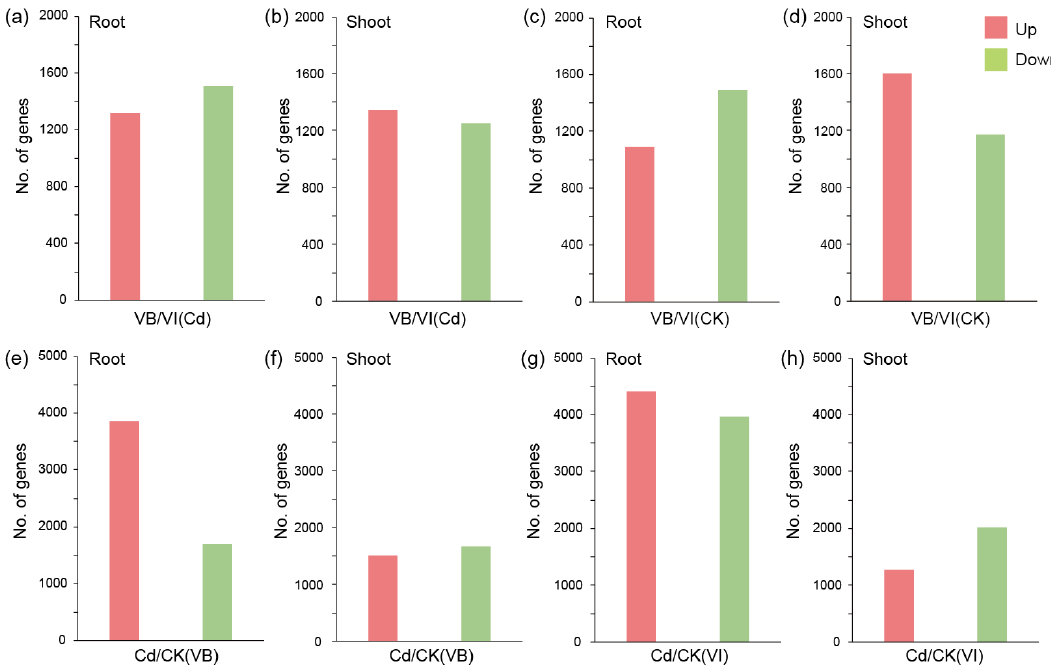
Figure 3. Differentially expressed genes (DEGs) between Cd-treated and control samples in both Viola species. Numbers of the genes with significantly different transcription levels (up- or downregulated) between two species in roots ( a ) and shoots ( b ) under the Cd stressed condition, or in the roots ( c ) and shoots ( d ) of the control samples, were summarized for comparison. DEGs between the Cd treated and control samples in VB roots ( e ), VB shoots ( f ), VI roots ( g ), and VI shoots ( h ). CK, control; VB, Viola baoshanensis ; VI, Viola inconspicua .